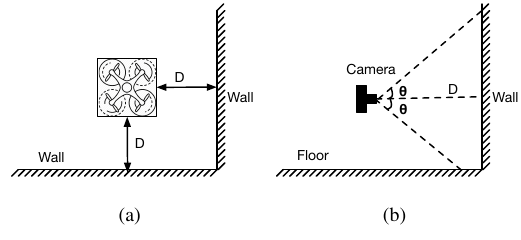
Figure 2. (a) safety distances for data acquisition as seen from above the QUAV, (b) the FOV of the camera carried by the QUAV from a side-looking vantage